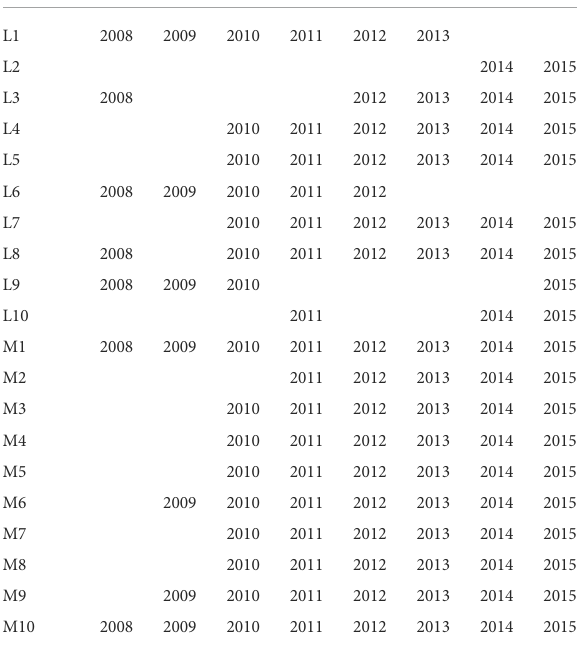
TABLE 1 Time spans of